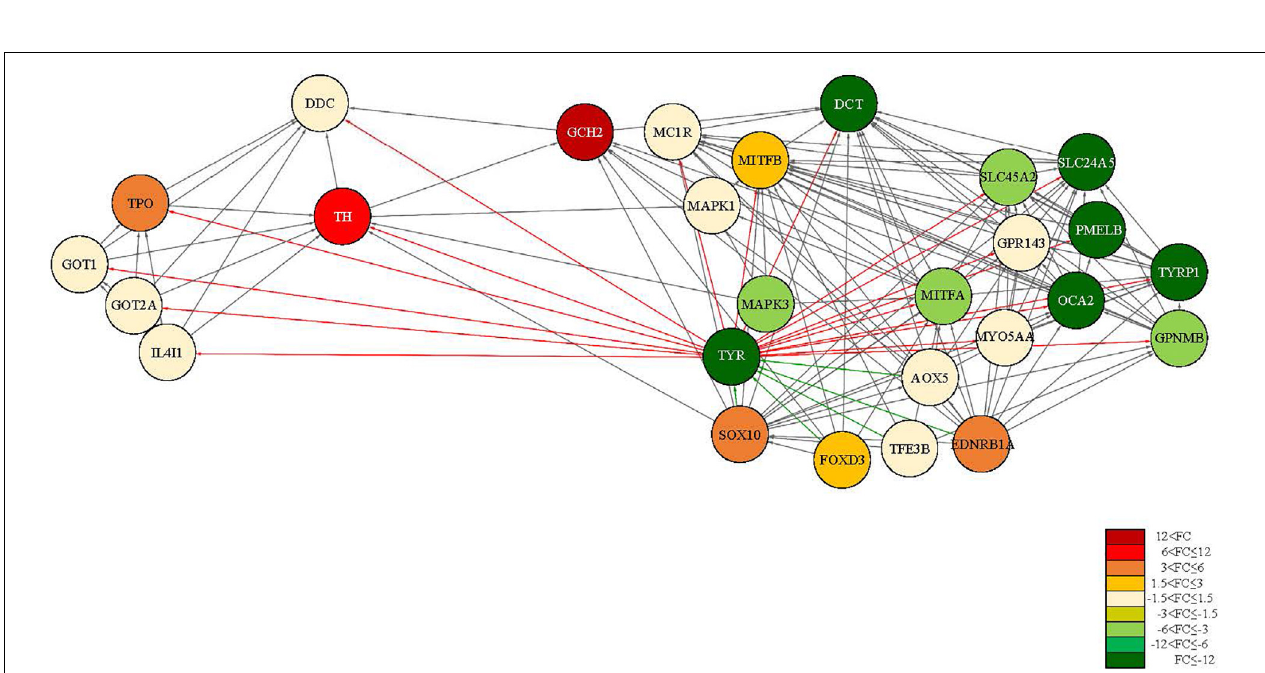
FIGURE 5 | PPI network map of tyrosine metabolism and melanogenesis-related proteins using STRING. The red series figure (light to dark) represents the up-regulated protein and the green series figure (light to dark) represents the down-regulated protein. The saturation is displayed differently according to FC. The red line direction expresses the distribution of proteins that are activated by TYR. And the green line direction expresses the distribution of proteins that influence the activation of TYR.